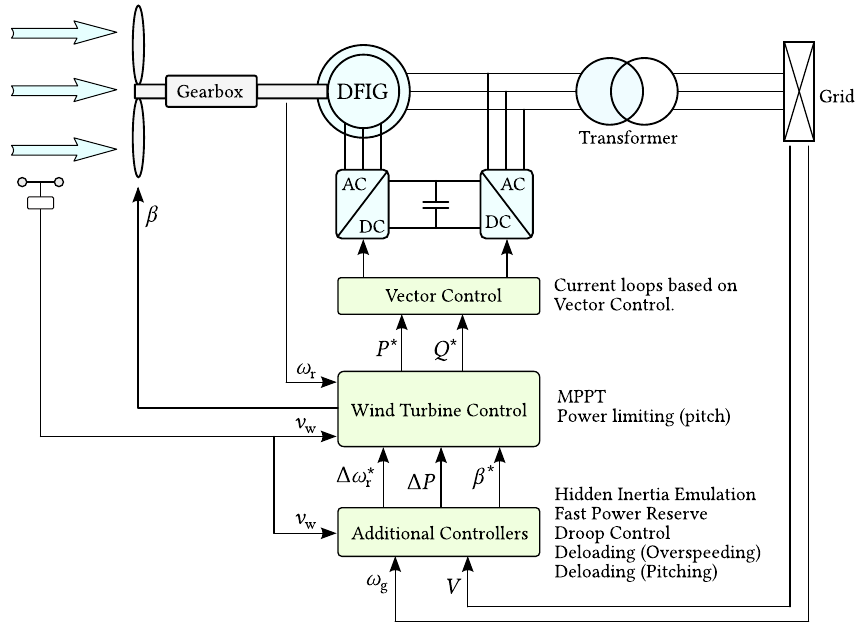
Figure 10. Control architecture in a type 3 WECS featuring a doubly fed induction